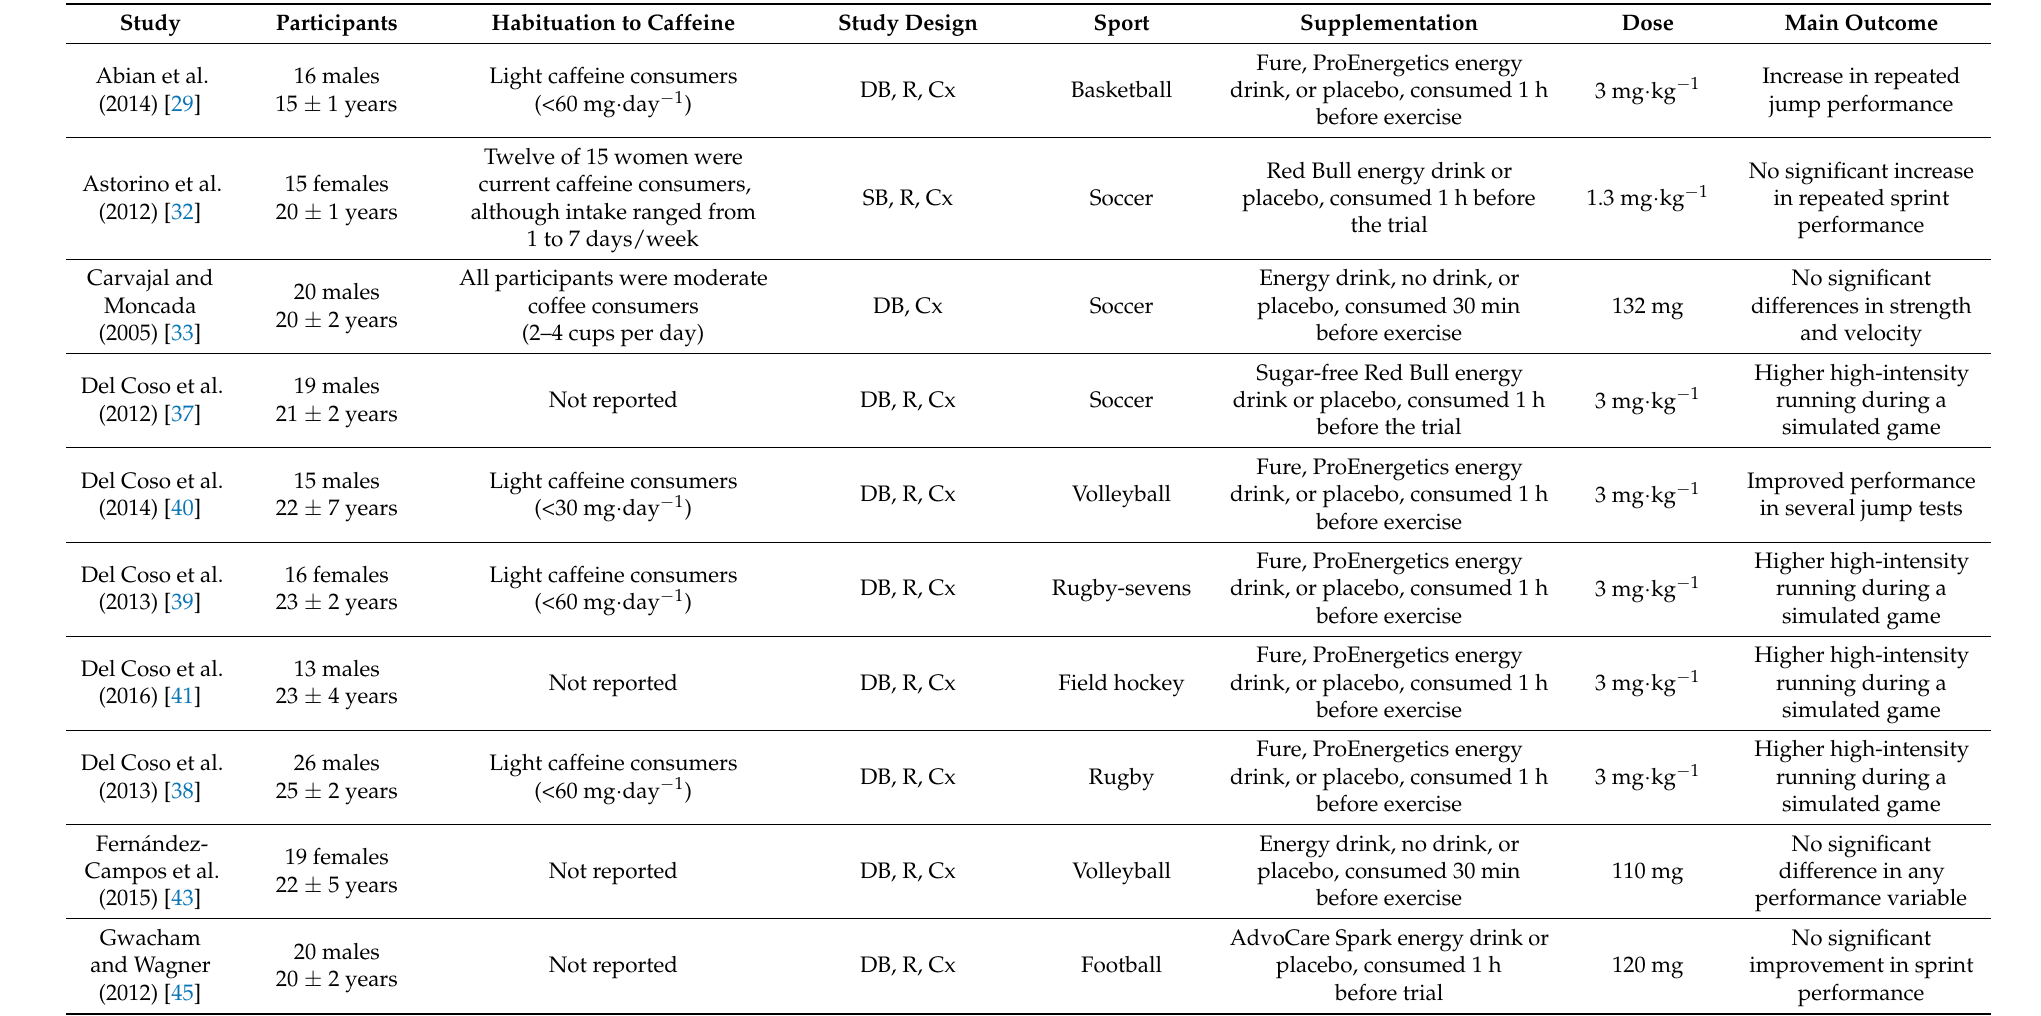
Table A3. Investigations in mixed-metabolism team